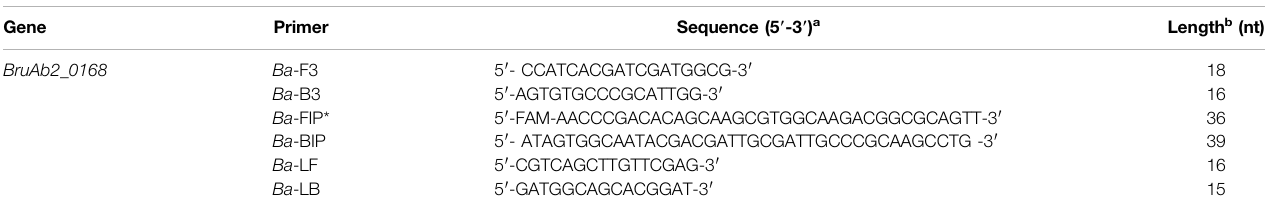
TABLE 1 | The primers used in the B. abortus -LAMP-LFIA